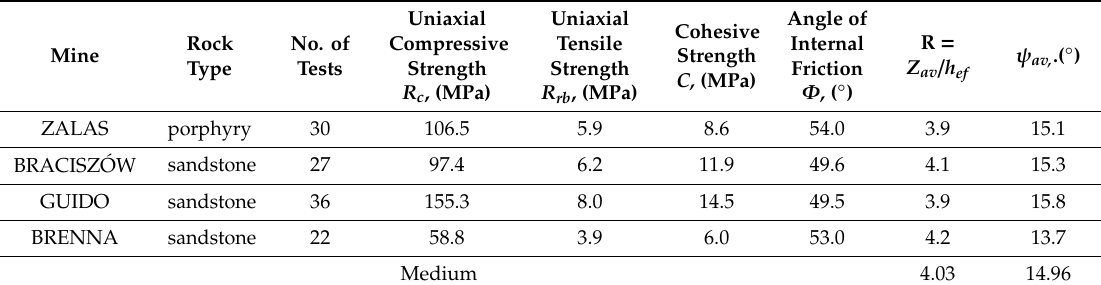
Table 1. Selected test results.